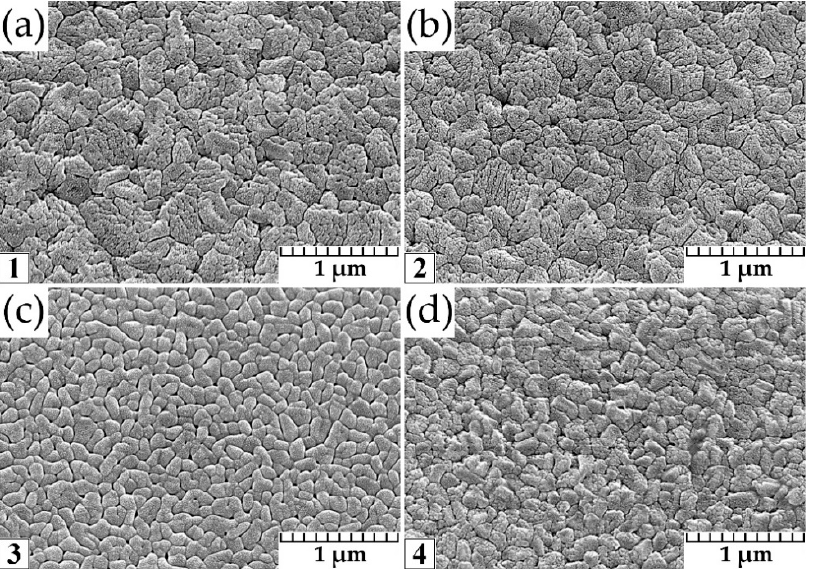
Figure 4. SEM images of surfaces of quasi-ordered valve metals functional thin films on the glass substrate (samples 1–4): ( a ) Al/Ta oxide; ( b ) Al/Ta annealed oxide; ( c ) Al/Va oxide; ( d ) Al oxide obtained in the oxalic electrolyte.